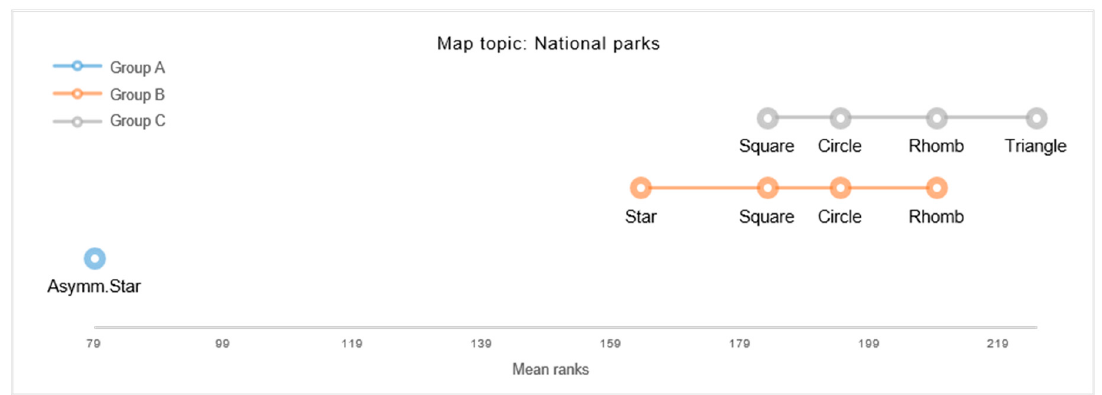
Figure 6. Map #2: Results of multiple pairwise comparisons, indicating groups of (dis)similar symbol-content congruence.